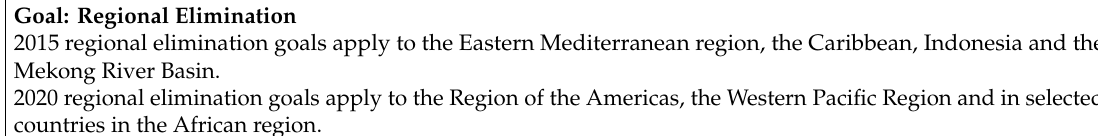
Box 4. Elimination goals for